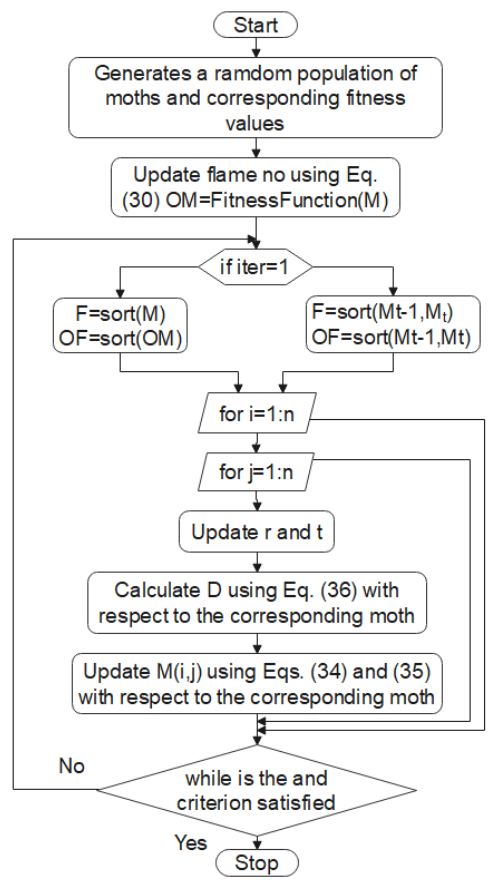
Figure 8. Flow chart of the moth-flame optimization